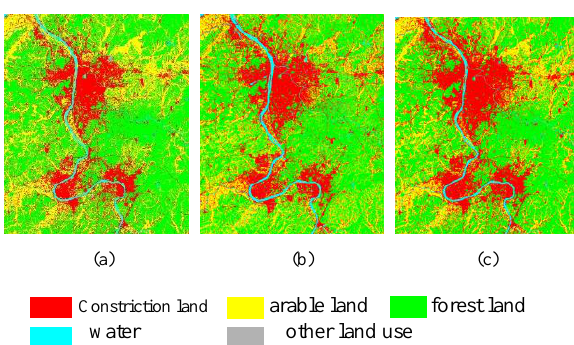
Figure 3. Comparison of modelled land use with actual land use: (a) 2010 actual land use, (b) 2013 actual land use, and